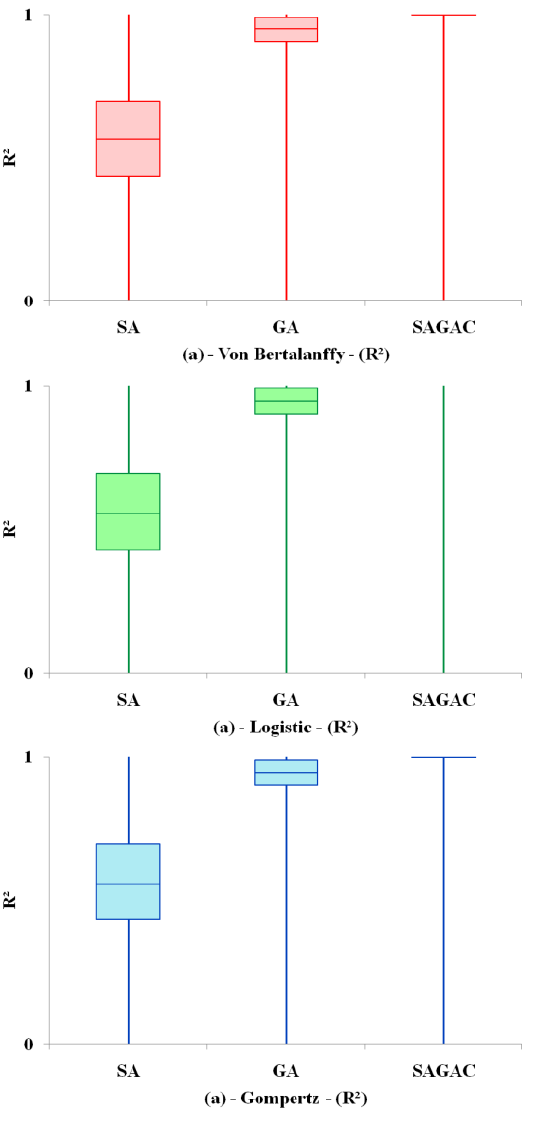
Figure 3. Descriptive analysis of experimental data of performance algorithms (SA, GA, and SAGAC) in growth curve optimization for broilers ( a ) and pigs ( b ).